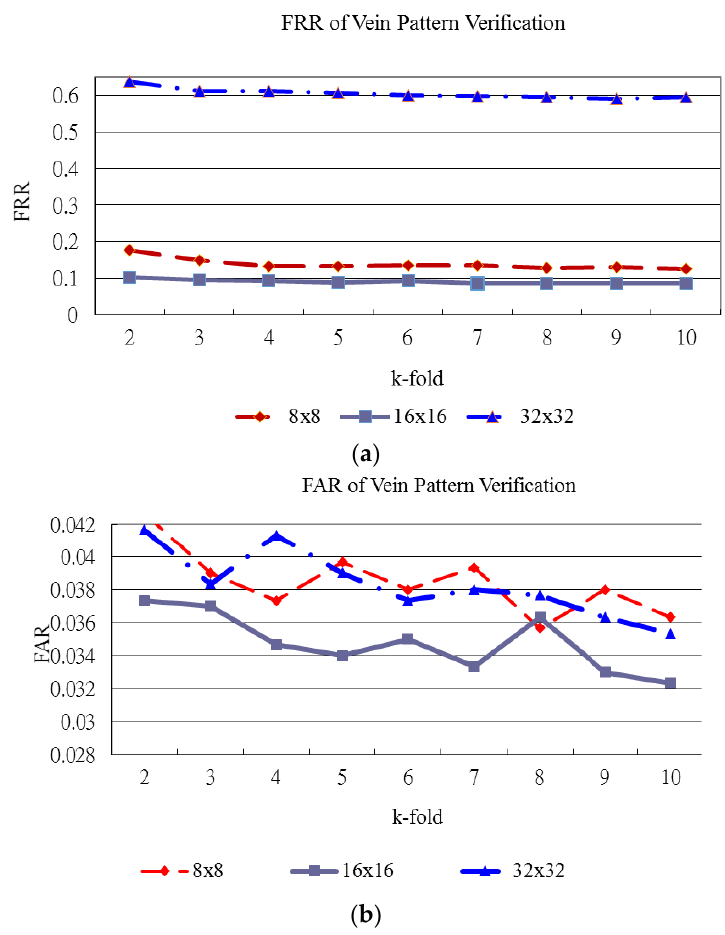
Figure 16. FRR and FAR for vein pattern verification. ( a ) FRR of vein pattern verification; ( b ) FAR of vein pattern verification.